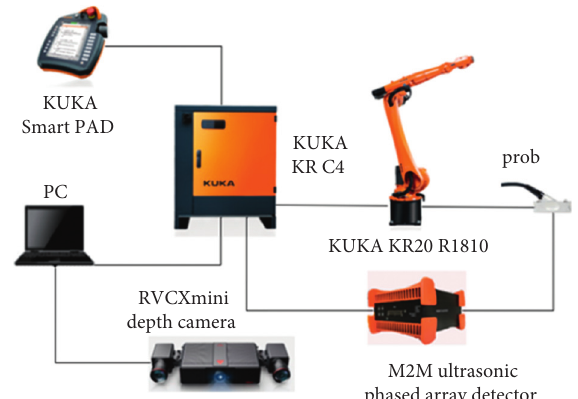
Figure 11: System